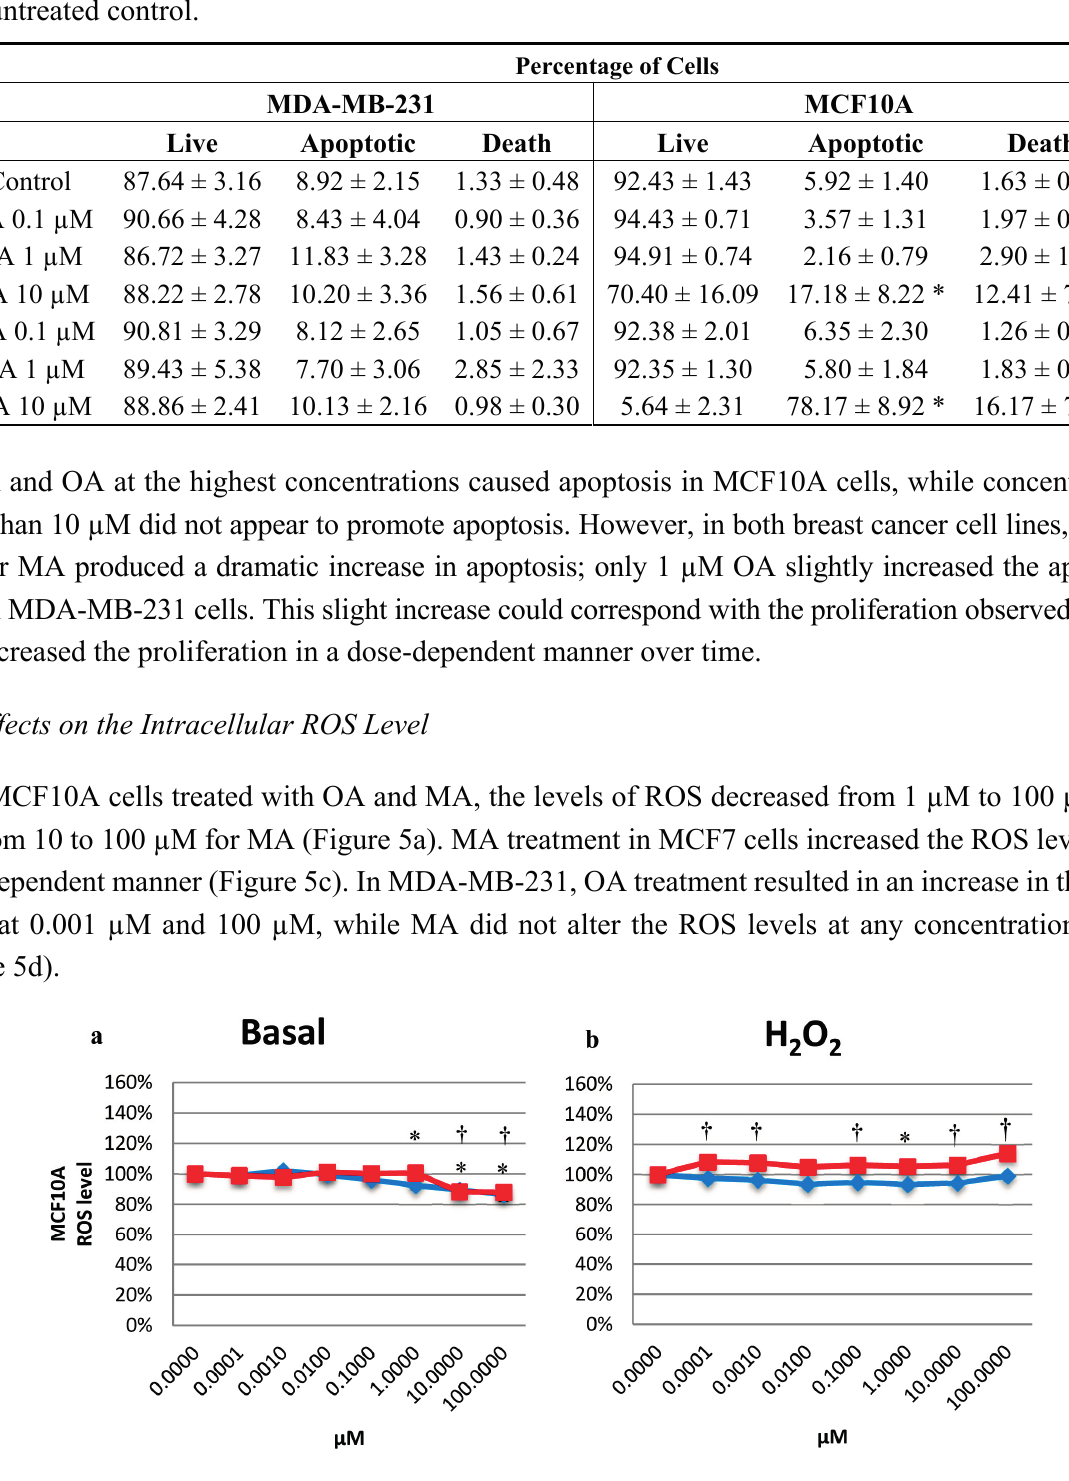
Table 2. Apoptosis of MDA-MB-231 and MCF10A cells treated with OA or MAS at 0.1 µM, 1 µM and 10 µM at 24 h. Values represent the mean ± SEM of three independent experiments.